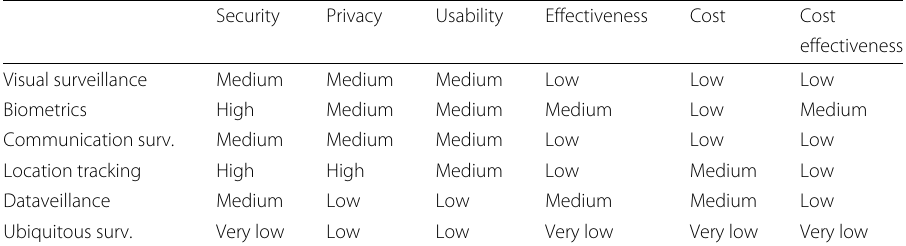
Table 4 Evaluation of surveillance and security technologies based on operators’ subjective perception Security Privacy Usability Effectiveness Cost Cost effectiveness Visual surveillance Medium Medium Medium Low Low Low Biometrics High Medium Medium Medium Low Medium Communication surv. Medium Medium Medium Low Low Location tracking High High Medium Low Medium Low Dataveillance Medium Low Low Medium Medium